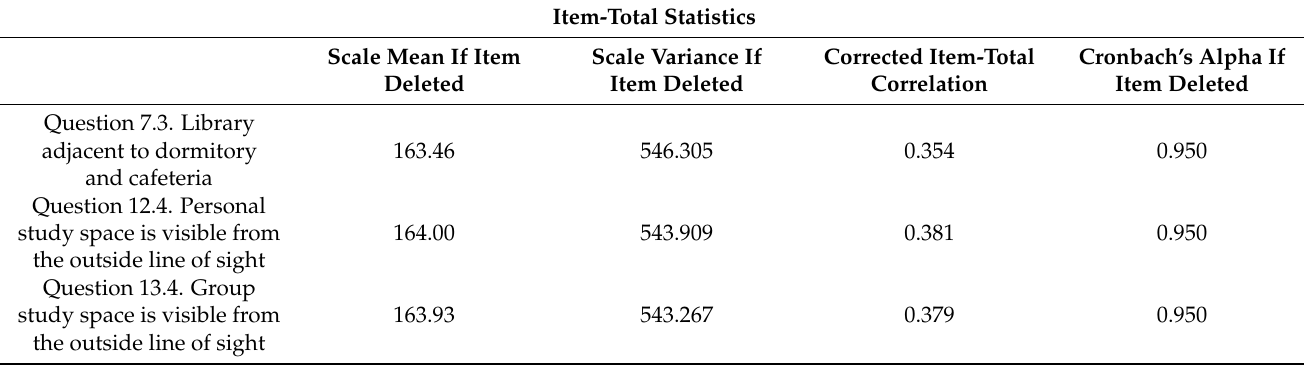
Table 6. Results for deleted items of the university library space user experience